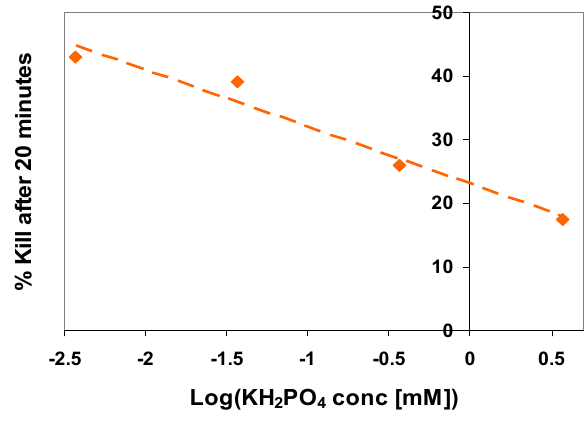
Figure 11. The effect of increasing concentrations of phosphate on the disinfection of E. coli. by P25 (Initial concentration 2.7 × 10 6 c.f.u.). measured as the % of bacteria no longer viable after 20 min